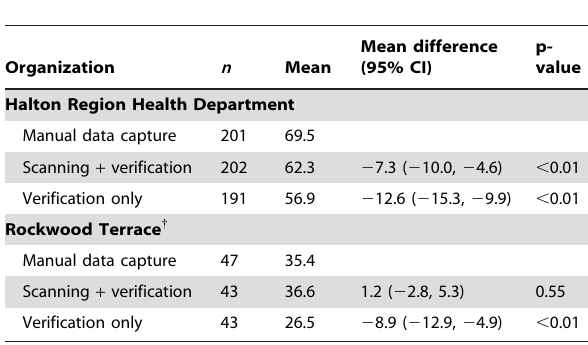
Table 1. Data capture: mean time (in seconds) per immunization